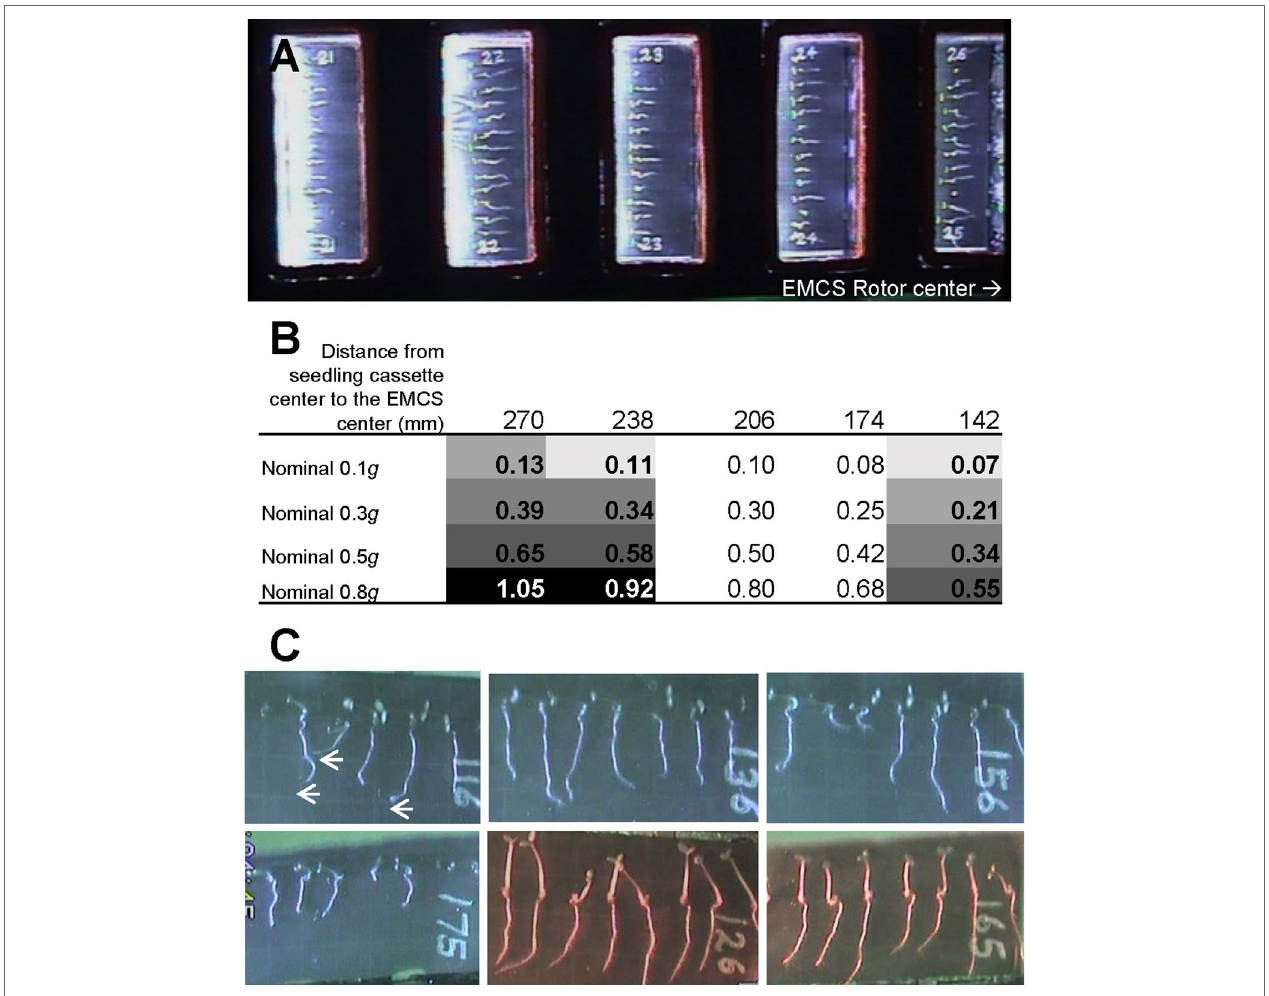
FIGURe 1 | Setup of SG1/SG2 experiment on board the International Space Station. (A) Image of an experimental container with 5 seedling cassettes inside the European Modular Cultivation System (EMCS) with the direction to the EMCS rotor center included. (B) Calculated g -level in each of the five culture chambers depending on the distance to the EMCS centrifuge rotor (note that only samples in the 3 positions in bold were included in this analysis, cassettes at 174 and 206 mm from EMCS center did not contain wildtype samples) and different EMCS rotational speed (nominal g value). Different background grey tones are used to indicate the samples that were used as replicates for low gravity (0.09 ± 0.02 g , 3 replicates), Moon gravity (0.18 ± 0.04 g , 3 replicates), Mars gravity (0.36 ± 0.02 g , 3 replicates) and reduced Earth gravity (0.57 ± 0.05 g , 4 replicates) and 1 g control (0.99 ± 0.06 g , 3 replicates) in addition to the microgravity samples (stopped centrifuge, 4 replicates). (c) Closer view of 6 day-old seedlings growing within a seed cassette at microgravity (CC116), low g (0.07 g , CC136), Moon g (0.21 g , CC156) or 1 g control (1.05 g , CC175) conditions with blue light stimulation (from the left). Hypocotyls show a clear positive phototropism at any g -level but roots only show this tropism at microgravity (arrows). For comparison, seed cassettes at low g (0.07 g , CC126) and 1 g control (1.05 g , CC165) conditions exhibiting root positive phototropism to red light stimulation (from the left) are provided (see Vandenbrink et al., 2016 for a detailed phototropism discussion).